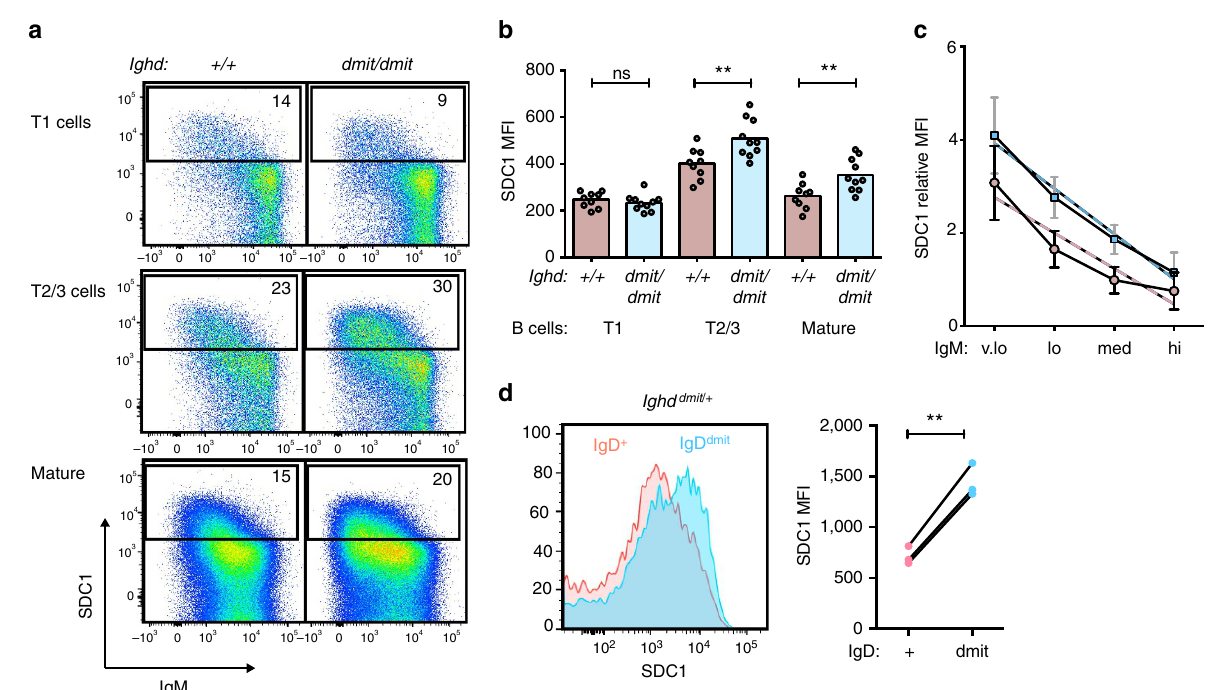
Figure 6 | IgD attenuates SDC1 induction independently of its effect on surface IgM. ( a – c ) Flow cytometric analysis of spleen cells from Ighd þ / þ and Ighd dmit/dmit mice. ( a ) Representative plots gated on the indicated subsets of B220 þ cells, and %SDC1 þ cells. ( b ) SDC1 MFI on the indicated B cell subsets in individual mice pooled from three independent experiments. Columns, arithmetic means. Statistical comparison by Mann–Whitney test: ** P o 0.01. ( c ) B220 þ cells were gated into four equal quartiles of surface IgM fluorescence: very low (v.lo), low (lo), medium (med) and high (hi), as shown in Supplementary Fig. 14. Shown for each quartile is the mean and s.d. SDC1 MFI, expressed relative to the MFI of B cells in the same experiment from a fluorescence minus one control sample where the SDC1 antibody was omitted. Data from n ¼ 7 Ighd þ / þ (red) and n ¼ 7 Ighd dmit/dmit (blue) mice pooled from two experiments. Dashed lines are best fit by linear regression analysis. Statistical comparison of linear regression: slopes, ns; intercepts, P o 0.0001. ( d ) Histograms of SDC1 fluorescence on T3 (IgM low CD93 þ CD23 þ ) spleen B cells from heterozygous Ighd dmit/ þ mice, gated as shown in Supplementary Fig. 9, on IgD high cells expressing the wild-type Ighd allele (red), and on IgD low cells expressing the mutant Ighd allele (blue). Graph shows SDC1 MFI on Ighd dmit and Ighd þ T3 B cells within the same individual mouse connected by lines. Statistical analysis by paired t -test: ** P o 0.01. Representative of two independent experiments and n ¼ 8